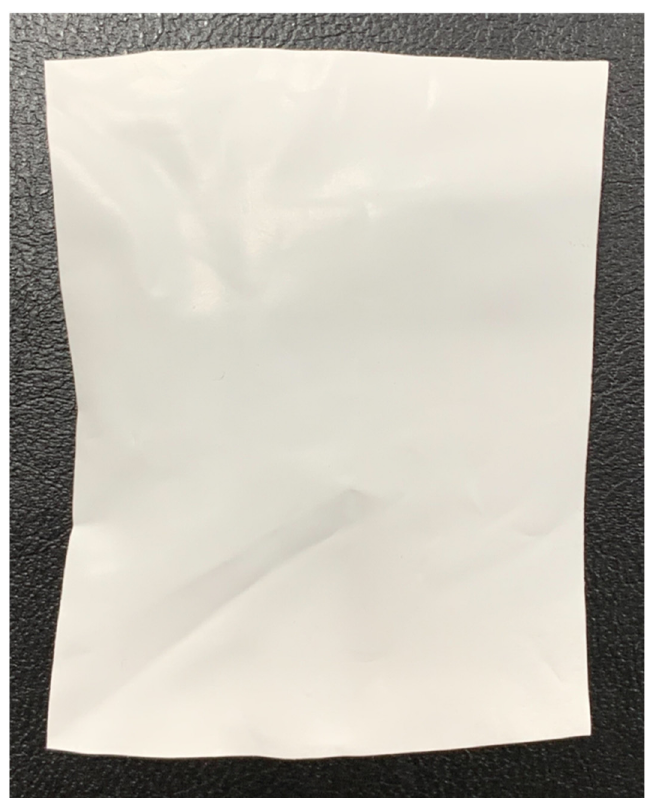
Figure A1. The photo of a PVDF membrane prepared by immersing the PVDF/NMP (20 wt% of PVDF) solution in water.